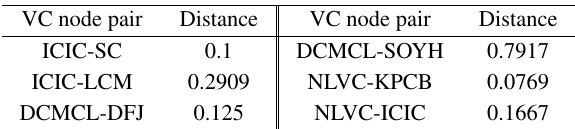
Table 10 Distance between various VC industry leaders.